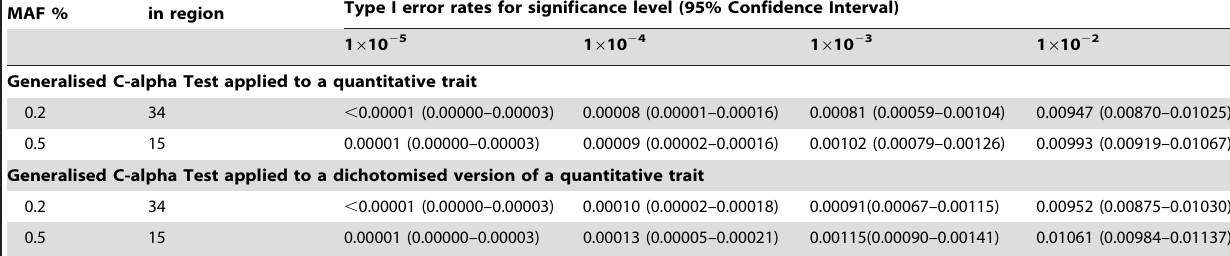
Table 1. Null simulations.